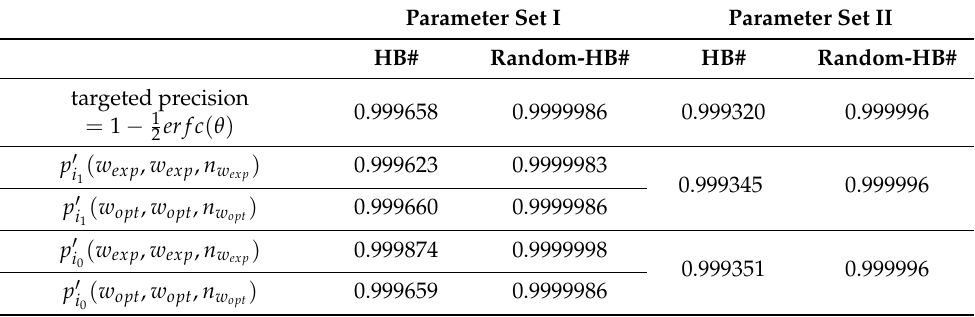
Table 6. Precision of the proposed PB-OOV algorithm meets the targeted precision for bit recovery. Parameter Set I